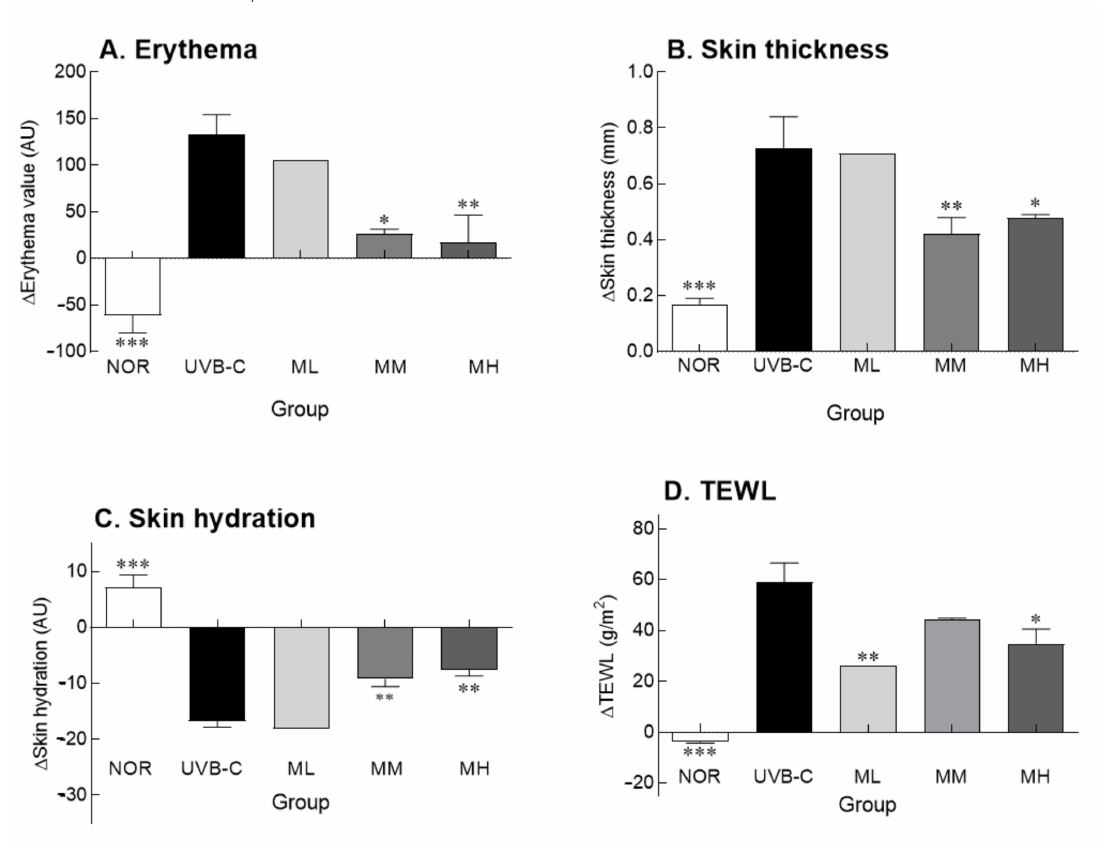
Figure 1. Effects of milk phospholipids on erythema formation ( A ), skin thickness ( B ), skin hydration ( C ) and transepidermal water loss (TEWL) ( D ) in ultraviolet (UV) B-irradiated hairless mice. NOR: oral administration of saline without UVB irradiation; UVB-C: oral administration of saline under UVB irradiation; ML: oral administration of low-dose (50 mg/kg b.w.) milk phospholipids under UVB irradiation; MM: oral administration of medium-dose (100 mg/kg b.w.) milk phospholipids under UVB irradiation; MH: oral administration of high-dose (150 mg/kg b.w.) milk phospholipids under UVB irradiation. Data are expressed as means ± standard error ( n = 6). * p < 0.05, ** p < 0.01, and *** p < 0.001 vs. UVB-C group (Tukey’s